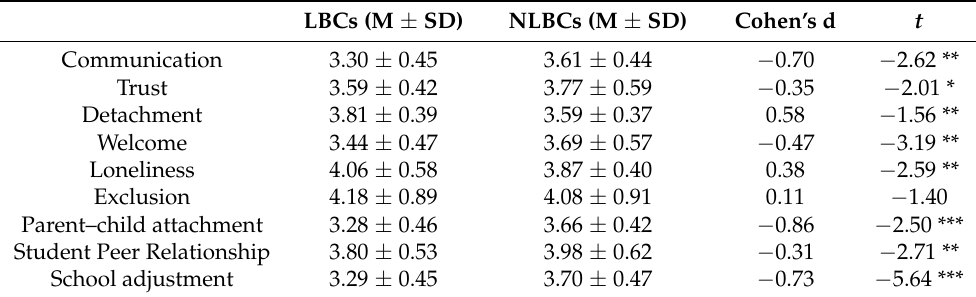
Table 1. Descriptive statistics of each variable of transnational parenting of left-behind children (LBCs) and non-left-behind children (NLBCs) (n = 594). LBCs (M ± SD) NLBCs (M ± SD) Cohen’s d t Communication 3.30 ± 0.45 3.61 ± 0.44 − 0.70 − 2.62 ** Trust 3.59 ± 0.42 3.77 ± 0.59 − 0.35 − 2.01 * Detachment 3.81 ± 0.39 3.59 ± 0.37 0.58 − 1.56 ** Welcome 3.44 ± 0.47 Loneliness Parent–child attachment 3.28 ± 0.46 Student Peer Relationship 3.80 ± 0.53 School adjustment